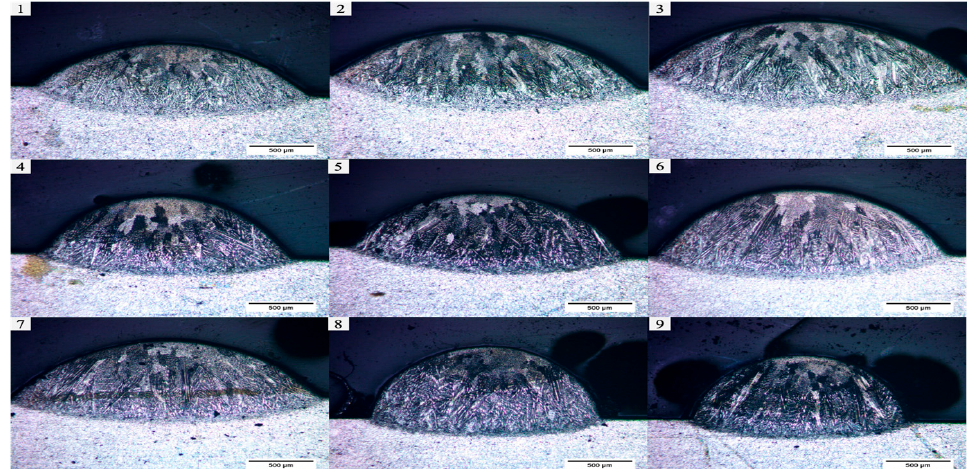
Figure 6. The transverse (perpendicular to the building direction) metallographic sections of the single-pass Inconel 718 samples. The processing parameters as well as characteristic measurements for the samples with corresponding parameter set numbers are presented in Table 5.